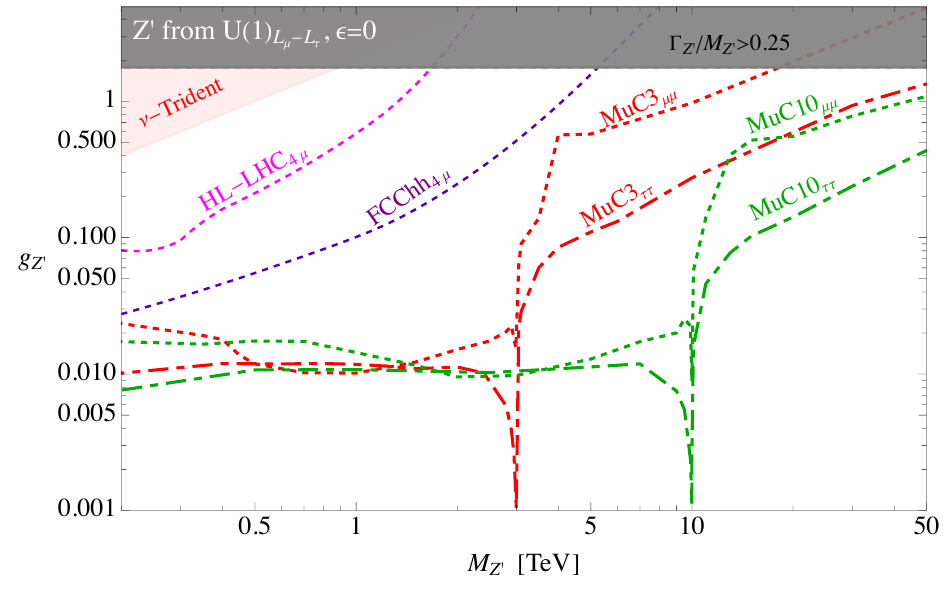
Figure 11 . Discovery reach at 5 σ for the L µ − L τ model with (cid:15) s = (cid:15) b = 0 in eq. (5.6). In the dark gray region the Z 0 has a large width, signaling a loss of